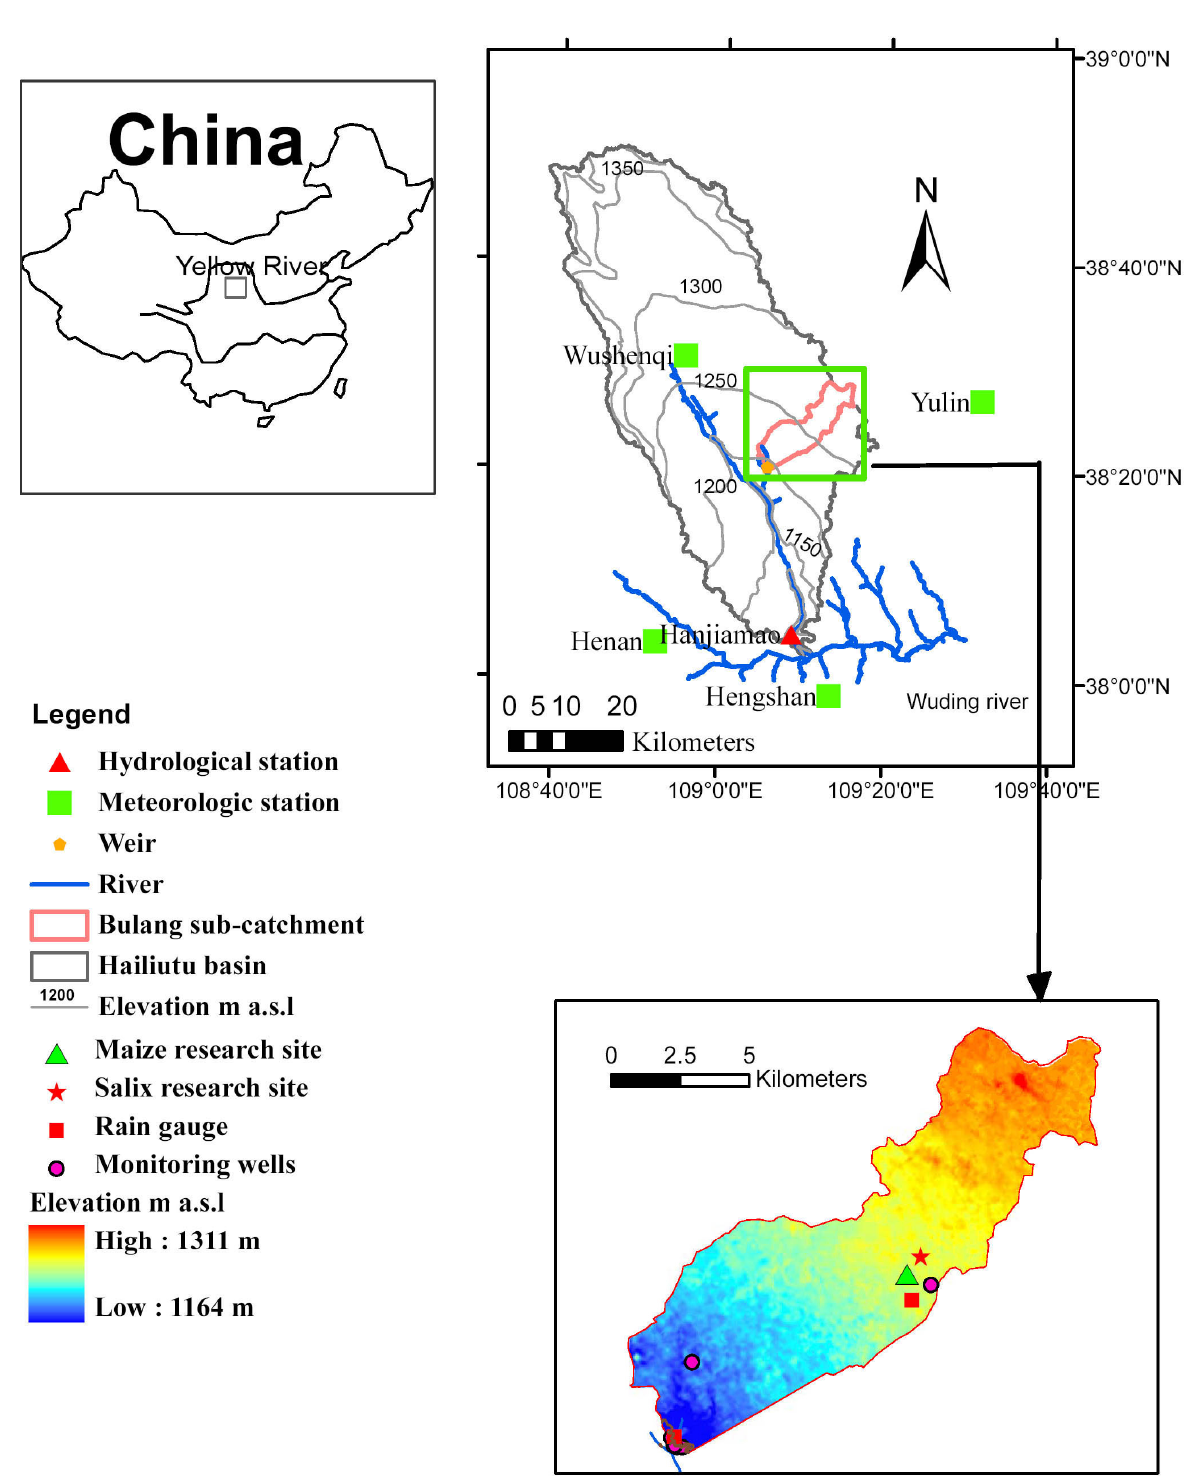
flow of maize, salix bush, and willow tree which were up scaled by using the NDVI generated vegetation cover from remote sensing data.